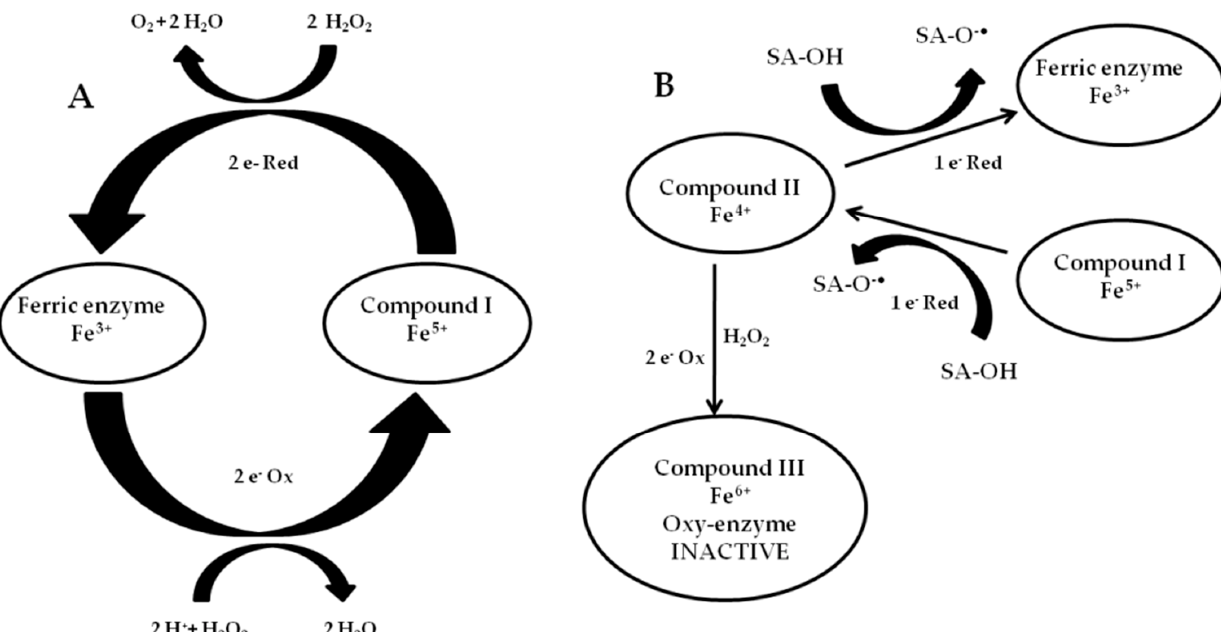
Figure 8. Catalytic cycles of CAT. ( A ) Two-electron equivalent transfer from Ferric enzyme (heme iron positive charges in ovals) to Compound I and vice versa; ( B ) One-electron reduction from Compound I to Ferric enzyme through Compound II; Compound II can be oxidized by H 2 O 2 into the inactive oxy-enzyme Compound III .